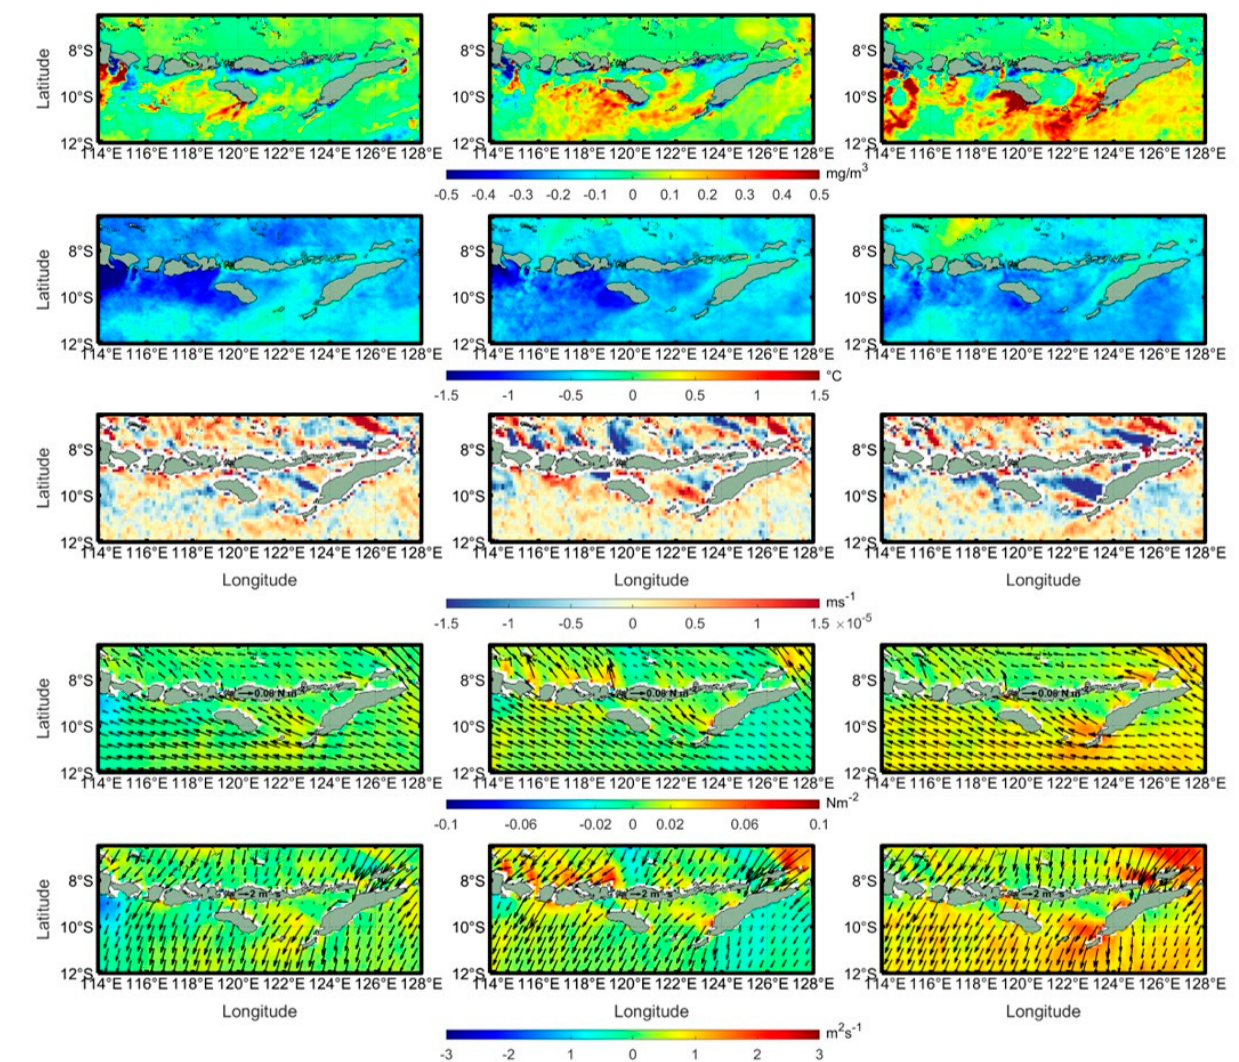
Figure 15. The anomalies of chlorophyll-a, sea surface temperature (SST), Ekman Pumping Velocity (EPV) wind stress, and Ekman Mass Transport (EMT) during the 2008 positive Indian Ocean Dipole (IOD) (June–August from left to right), respectively (from top to bottom). Additionally, during the 2016 negative IOD, the negative chl-a anomaly and the positive SST anomaly were more prominent along the southern coast of LSI. The highest positive SST anomaly (1.5 ◦ C) occurred in June 2016 along the southern coast of Bali. Both the positive SST anomaly and the negative chl-a anomaly were also followed by negative wind stress and EMT anomalies. In contrast, positive wind stress (0.02 Nm − 2 ) and EMT (1.5 m 2 s − 1 ) anomalies occurred along the southern coast of East Java, and the eastern coasts of Sumba and Timor, in July 2016. However, both SST and chl-a concentrations had positive and negative anomaly values in these areas. Furthermore, we noticed a positive EPV value at the same time in these areas, which indicates downward water mass motion (downwelling). These results suggest that the variability in SST and chl-a along these areas are controlled by the wind stress curl (represented by EPV) rather than